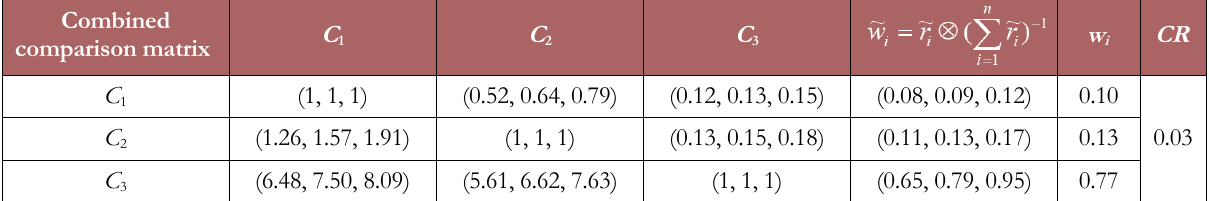
Table 3. The combined comparison matrix of six decision makers